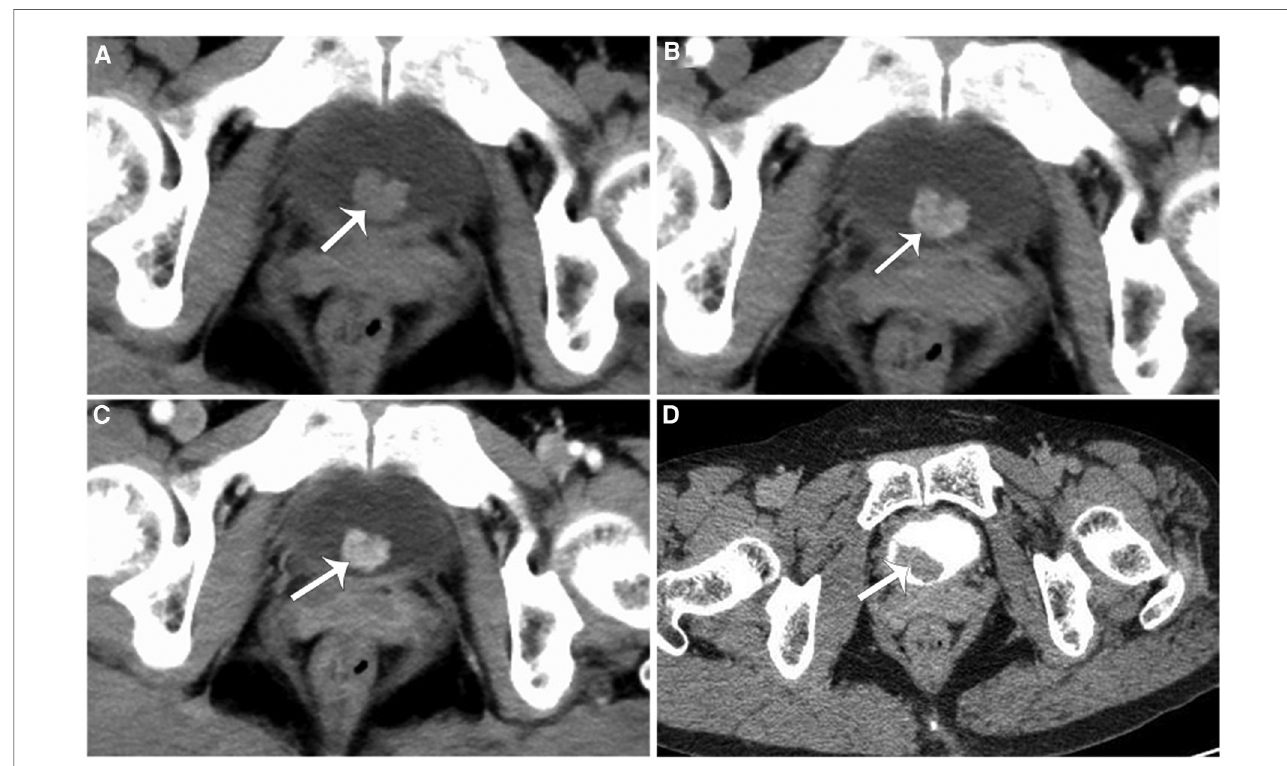
tomography urography (CTU) showed a soft tissue density fi lling defect in the right posterior lower wall of the bladder.